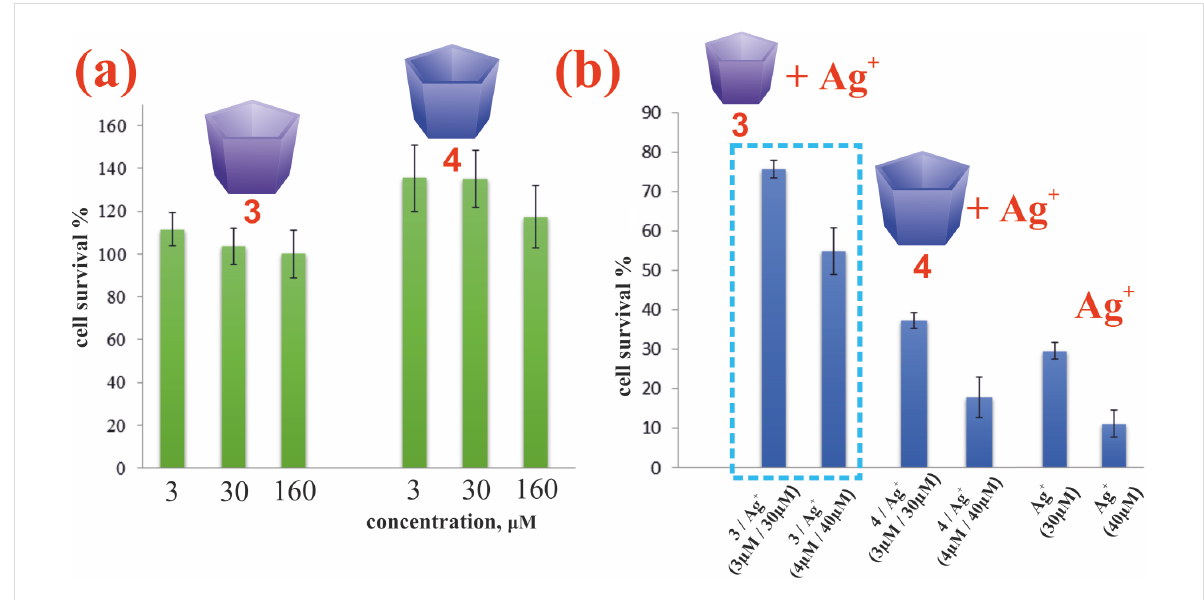
Figure 5: (a) Evaluation of the effect of pillar[5]arenes 3 and 4 on the viability of A549 cells ( p ≤ 0.05); (b) Evaluation of the effect of associates of 3 /Ag + on the viability of A549 cells ( p ≤